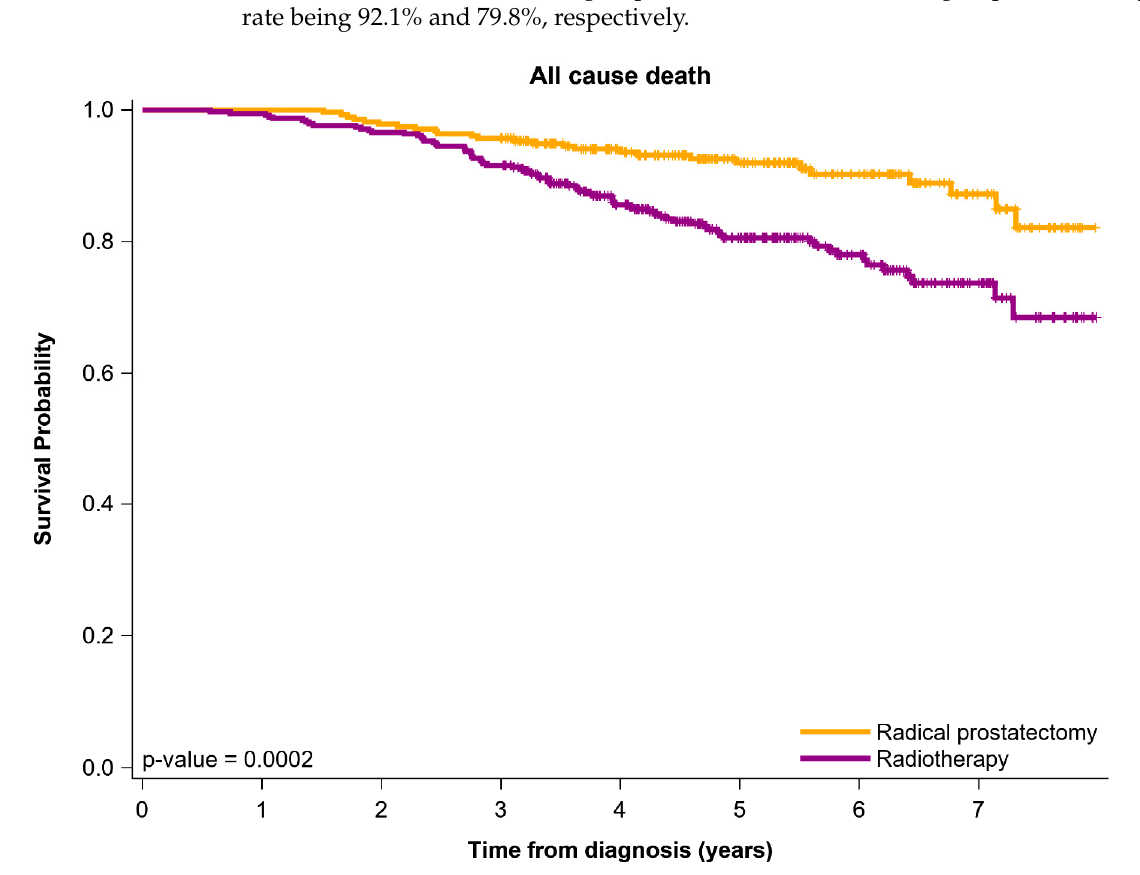
Figure 1. Plots of survival for outputs of patient with AV-LPC receiving different curative-intent treatments utilizing the Kaplan–Meier method: Propensity